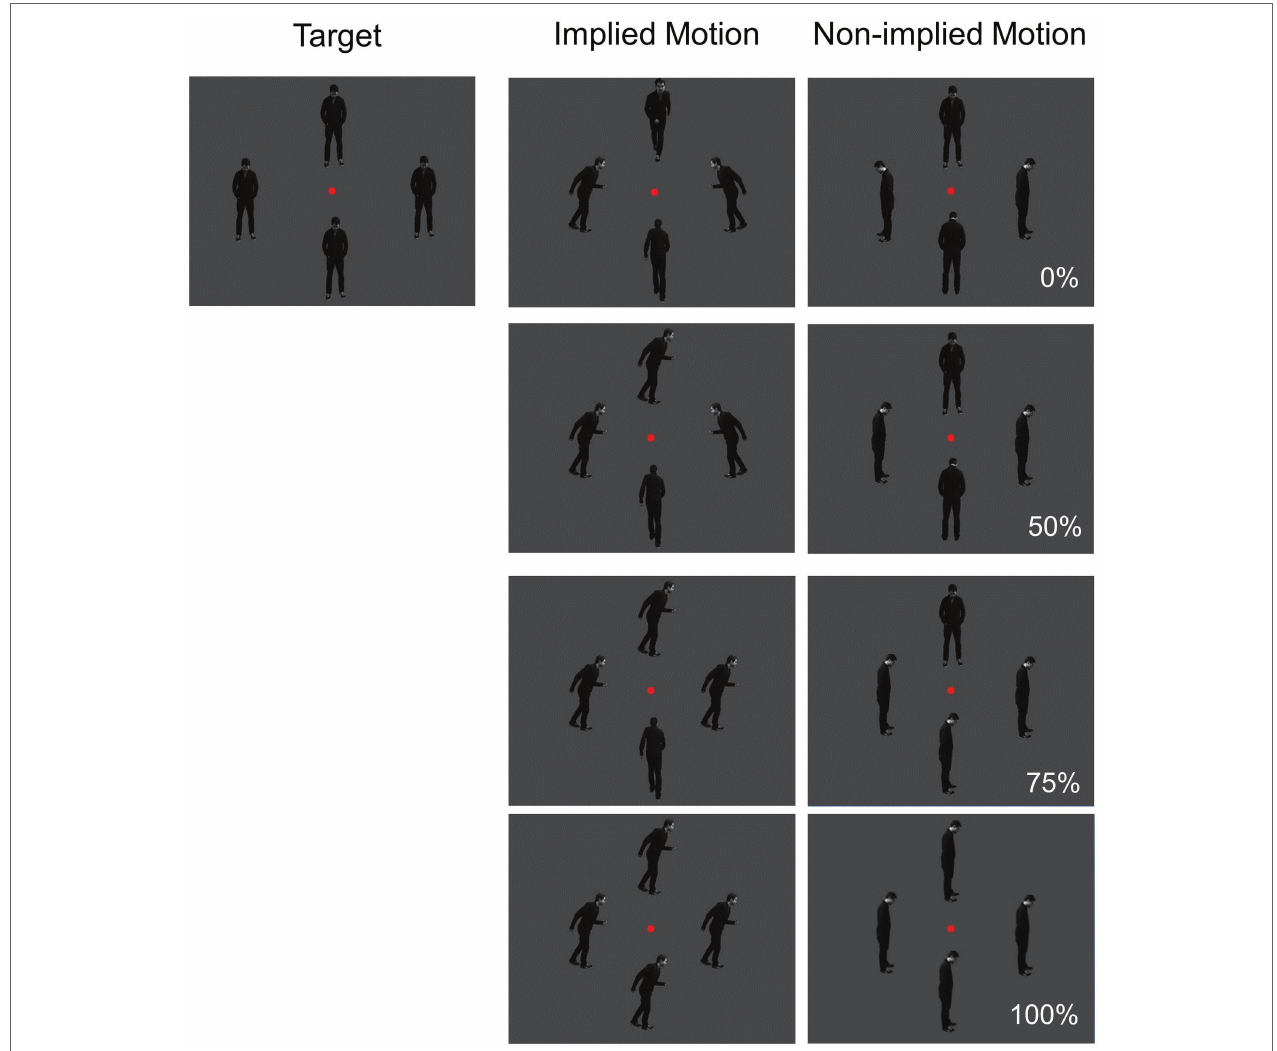
FIGURE 1 | Visual stimuli used in the study. Directional coherence (0, 50, 75, and 100%) and implied motion (IM; non-IM) were